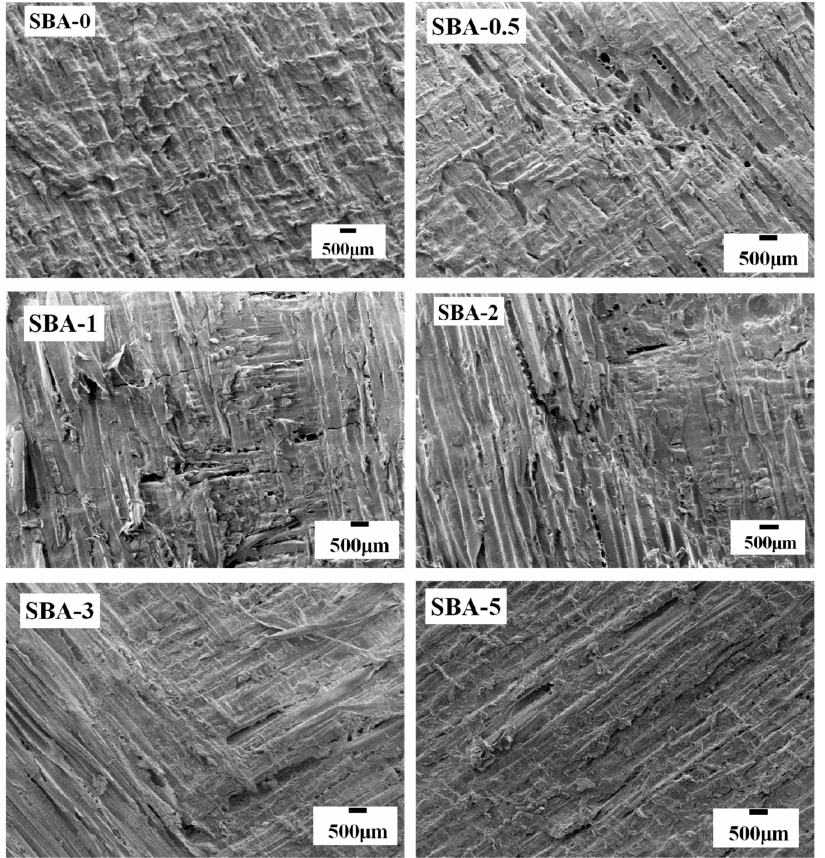
Figure 7. SEM micrograph of the fracture surfaces of plywood samples glued with the